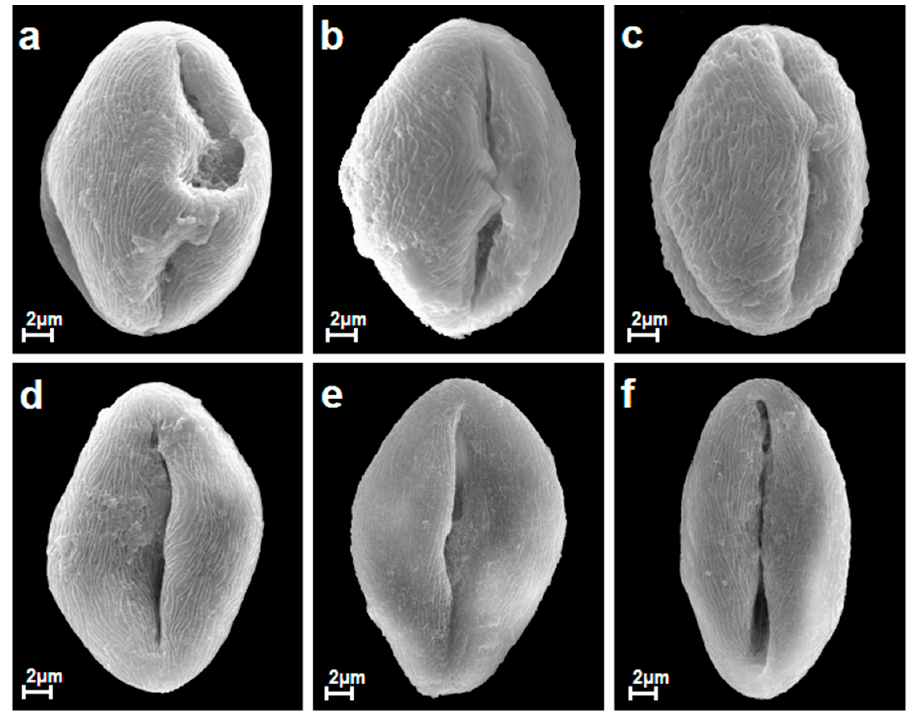
Figure 5. Pollen grains of Rubus bifrons , R. idaeus , R. sulcatus , R. radula , R. nessensis and R. gracilis in equatorial view, ( a – f ).